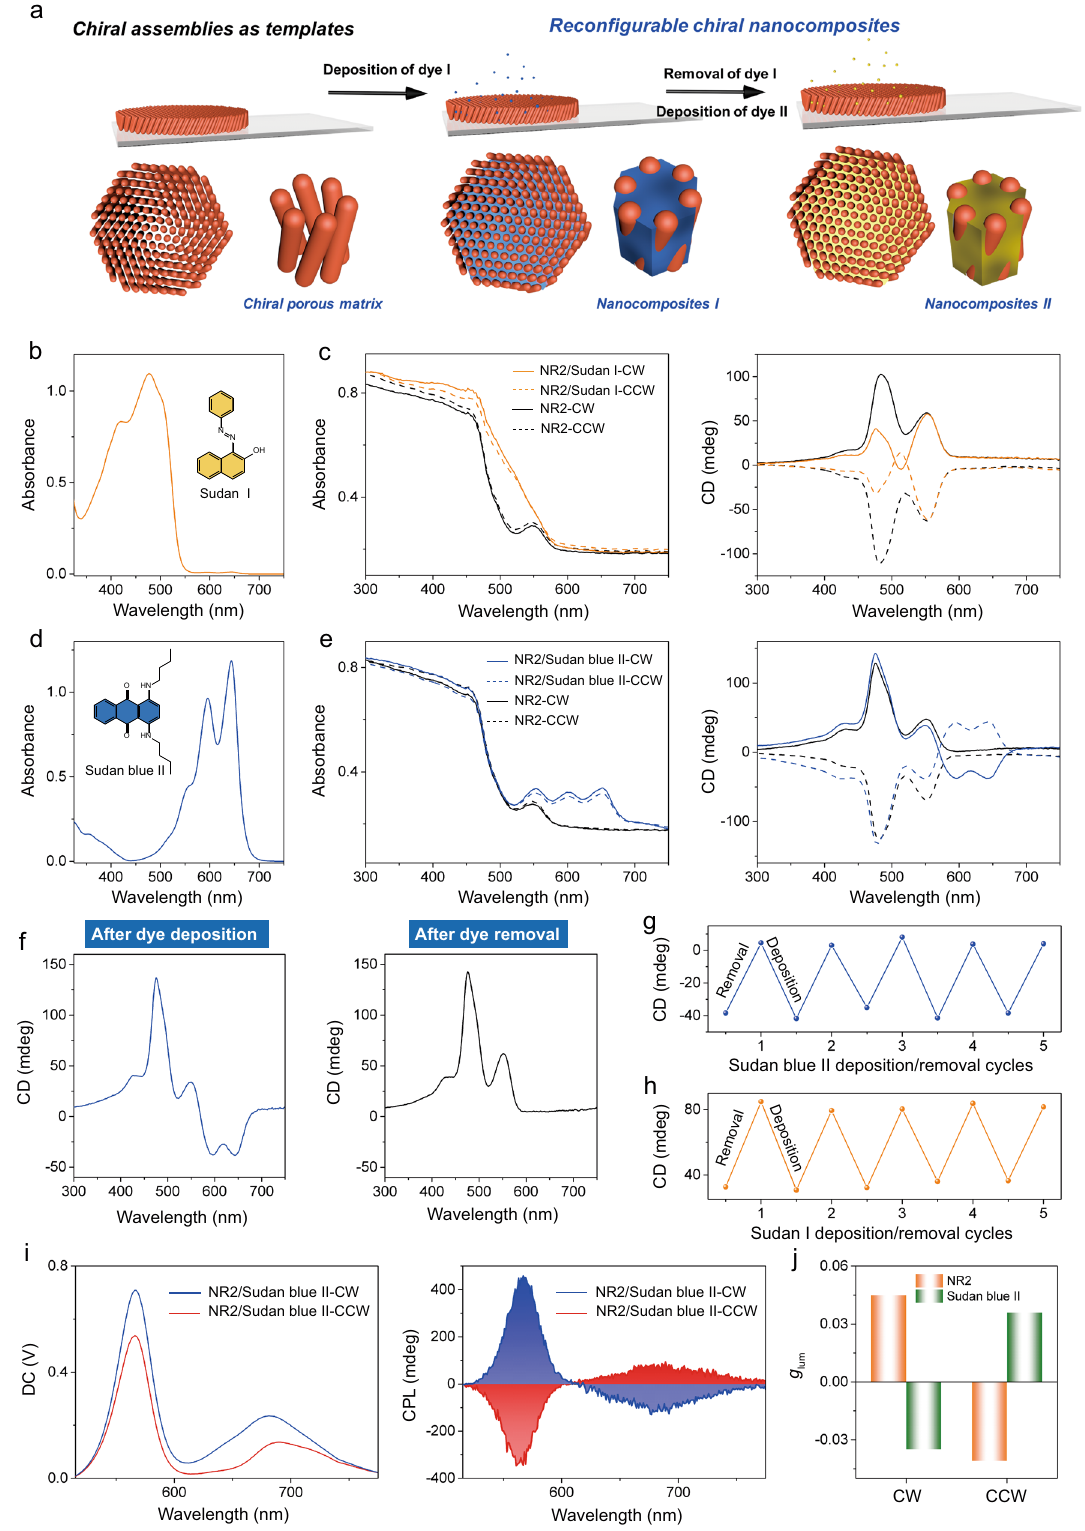
Fig. 5 | Chirality transfer from the NR assemblies to the molecular systems. a Scheme of deposition-removal of dye on NR assemblies, which shows chirality transfer from the NR assemblies to the dye molecules. b UV − Vis absorption spec- trum of Sudan I. c UV − Vis absorption spectra and CD spectra of NR2/Sudan I-CW, NR2/Sudan I-CCW, NR2-CW, and NR2-CCW. d UV − Vis absorption spectrum of Sudan blue II. e UV − Vis absorption spectra and CD spectra of NR2/Sudan blue II-